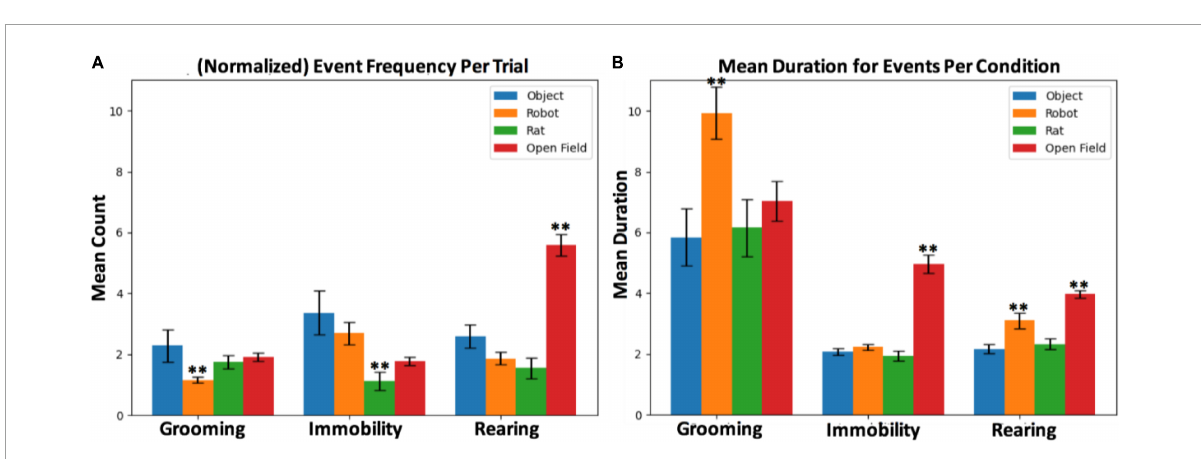
FIGURE6 (A) Mean counts per trial and (B) mean duration per condition for grooming, rearing and immobility events. The ** symbol refers to statistically significant differences based on hypothesis